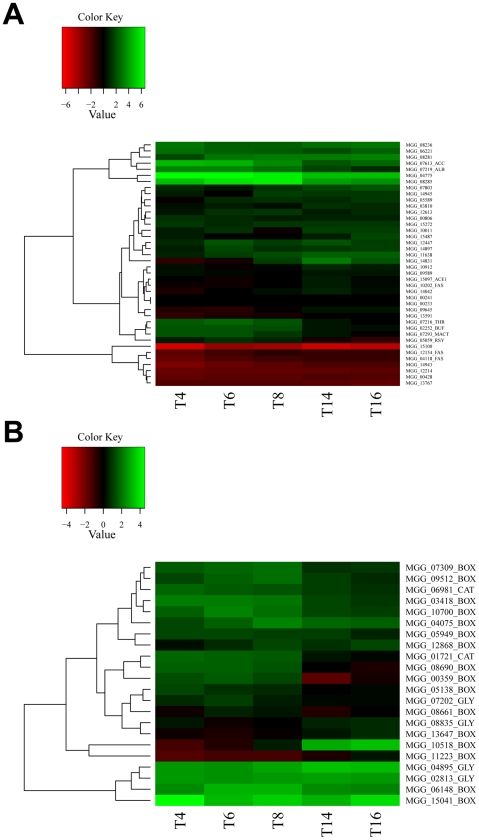
Heatmaps showing levels of transcript abundance during time course of appressorium development.Levels of expression are represented as moderated log2 ratio of transcript abundance compared to mycelium grown in complete medium. Values are from 4 h (T4) to 16 h (T16) after conidia were placed on a hydrophobic surface. Genes showing similar patterns of gene expression are clustered. A. Genes encoding enzymes from pathways that utilise malonyl-CoA. Specifically labelled are acetyl-CoA carboxylase (ACC), malonyl CoA-acyl carrier protein trans-acylase (MACT), fatty acid synthase (FAS), components of melanin biosynthesis pathway (ALB, BUF, RSY, THR) and the PKS-NRPS hybrid ACE1. B. Genes encoding enzymes involved in β-oxidation of fatty acids and the glyoxylate cycle. Genes are labelled according to pathways: fatty acid β-oxidation (BOX), glyoxylate cycle (GLY) and carnitine acetyl-transferases (CAT).